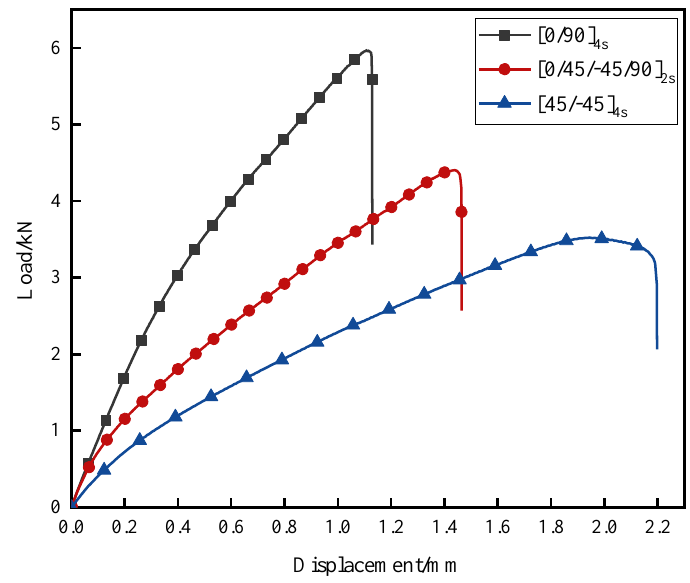
Figure 4. Typical load–displacement curves of the joints. Table 4. Failure loads and displacements of the joints.